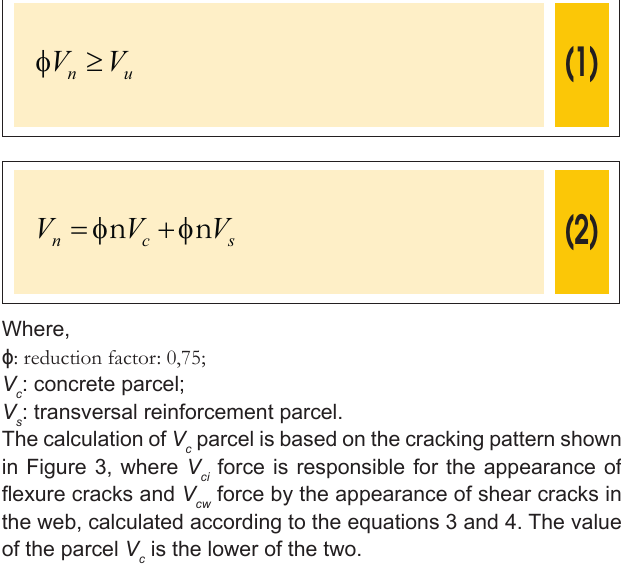
reinforced concrete beam (ACI